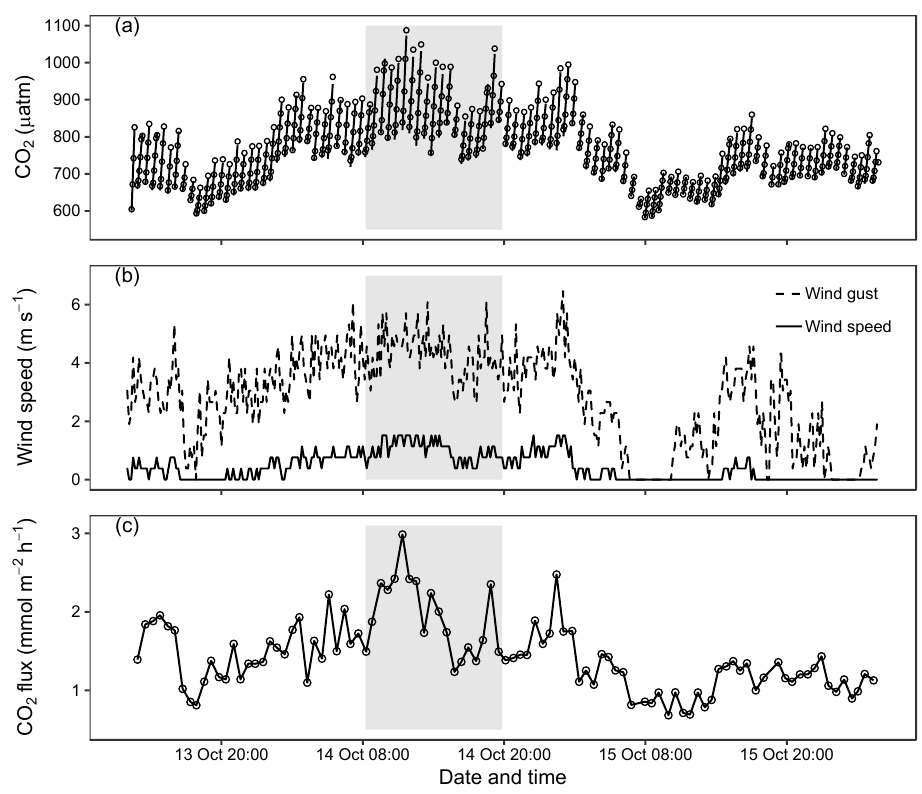
Figure 5. Data from field deployment (13–15 October) including the time period depicted in Fig. 3 (grey box). (a) The headspace CO 2 partial pressure (µatm) in the automated floating chamber during flux measurement when the air pump is off (open points) fitted with a linear regression (solid lines), (b) the wind speed (solid line, ms − 1 ) and wind gust (dashed line, ms − 1 ) measured 30cm above the water surface and (c) the calculated CO 2 gas flux (mmolm − 2 h − 1